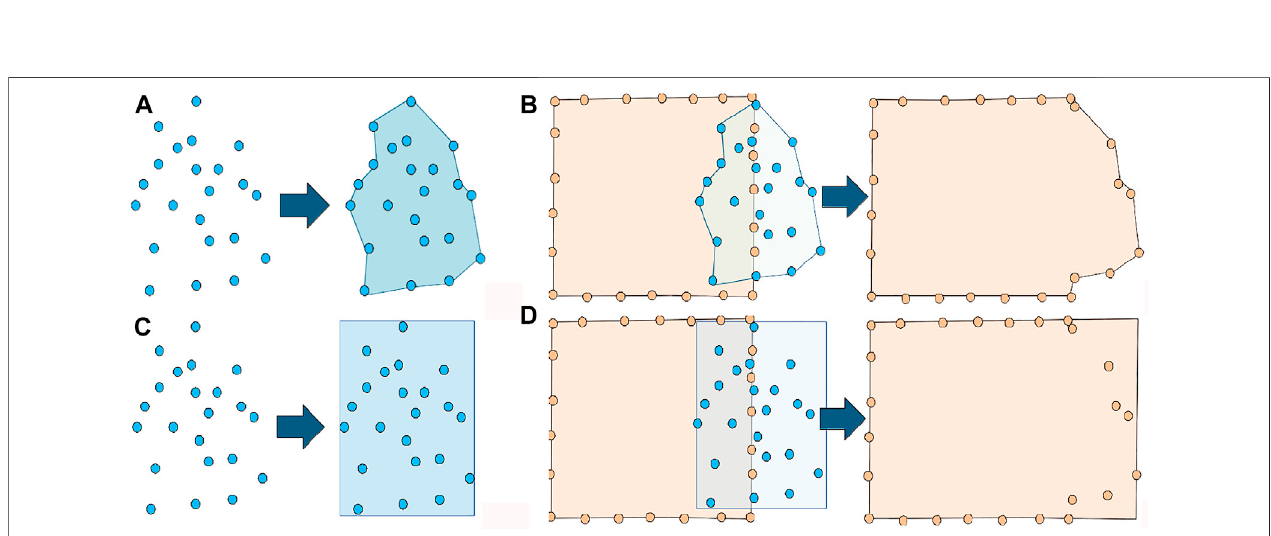
FIGURE 4 | Two techniques considered for plan boundaries. The fi rst one consists in computing the full concave hull of each cluster after the segmentation stage (A) , and then in repeating this algorithm in order to merge this cluster (detected at time t + 1) with one of the previous clusters (detected at time t ) (B) . The second technique consists in computing the minimal bounding box of a cluster (C) , and to update it after merging with a previous cluster (D) .